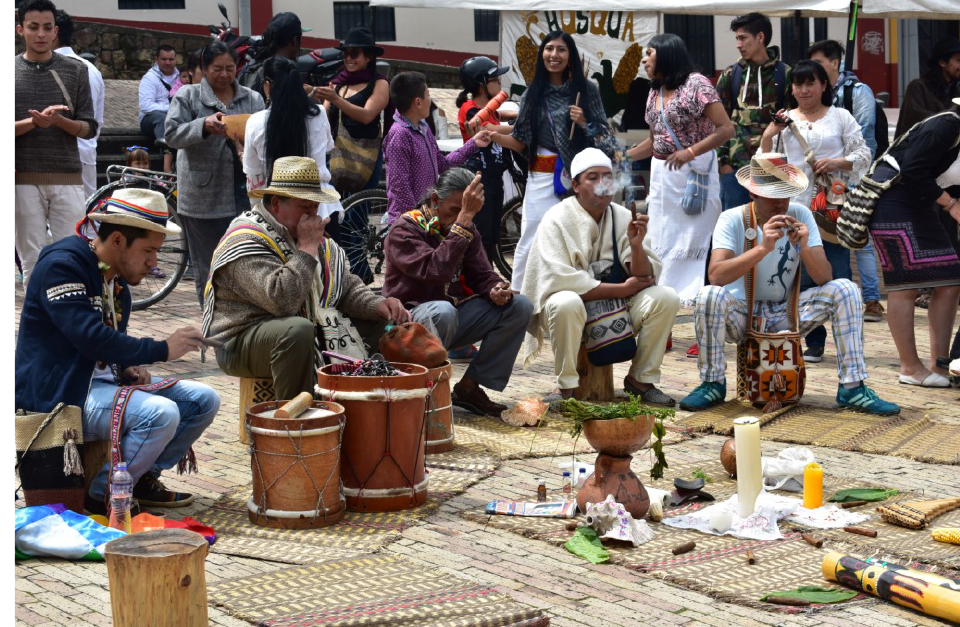
Figure 2. Quinoa and Corn Festival, June 2017. Members of the community using tobacco and coca leaves as a means to appropriate the main plaza of Suba in one of their main annual celebrations. On the back, women are sharing chicha , a symbolic fermented